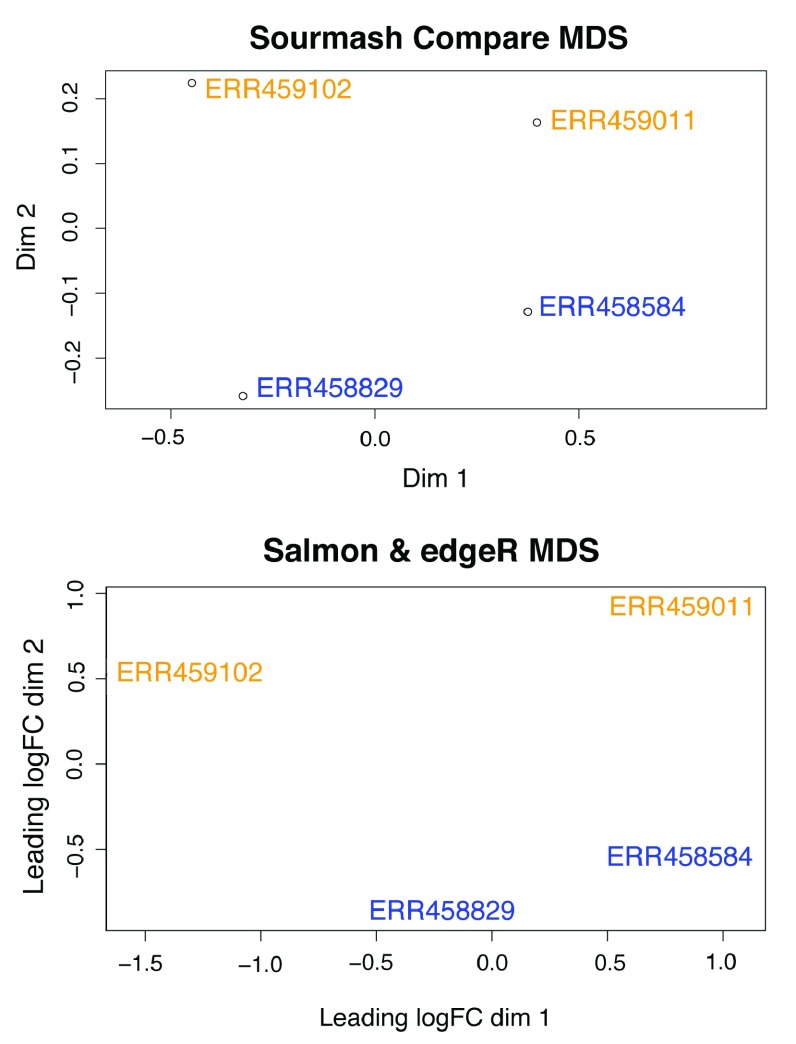
The MDS plots produced from the reference-free
sourmash compare similarity matrix and the transcript quantification analysis (salmon and edgeR) are similar.Wild-type
S. cerevisiae samples (ERR459011, ERR459102) are in yellow and mutant samples (ERR458584, ERR458829) in blue.